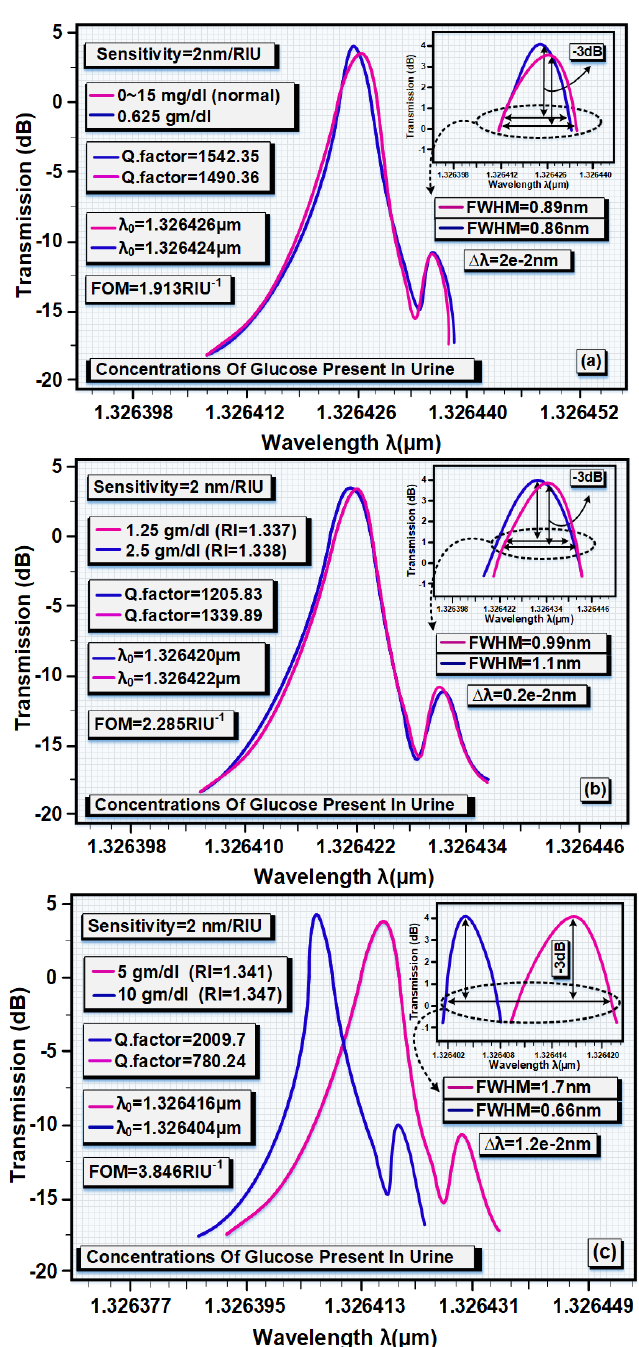
Figure 4. Detection of a normal person compared to a diseased person according to the glucose concentration in human urine in two cases ( a ) 0 ~ 15 mg/dL to 0.625 gm/dL, ( b ) 1.25 to 2.5 gm/dL, and ( c ) 5 to 10 gm/dL. Table 3. Parameters of refractive index, quality factor, sensitivity, as well as resonant wavelength for different values of glucose concentration in human urine.